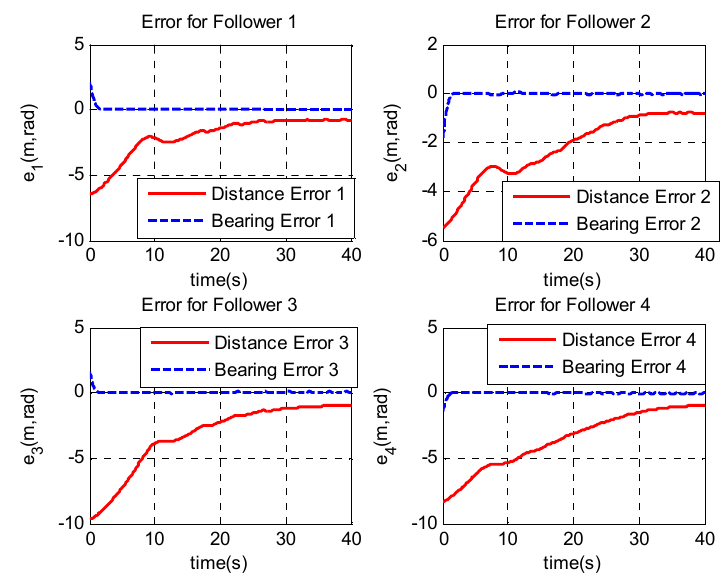
Figure 10. Relative distance and relative bearing errors of followers in Example 2.